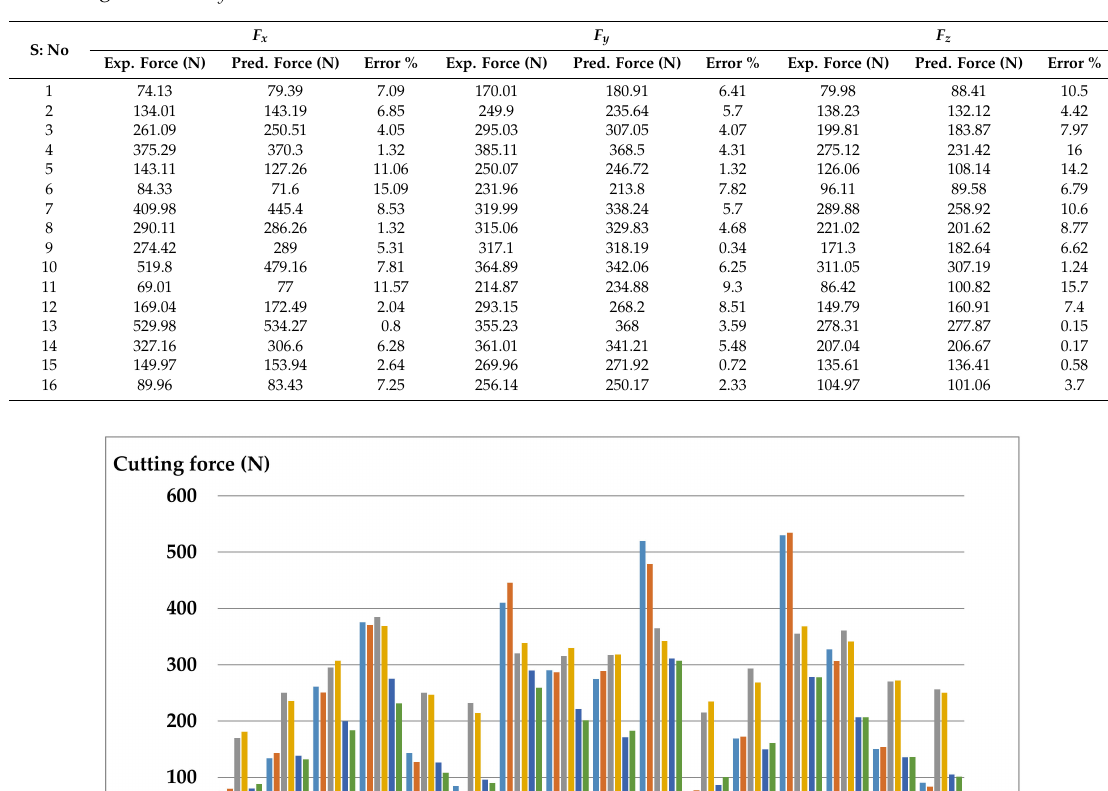
Table 6. The machining parameters and comparison of experimental cutting force F x , F y , F z vs. measured cutting force F x , F y , F z .